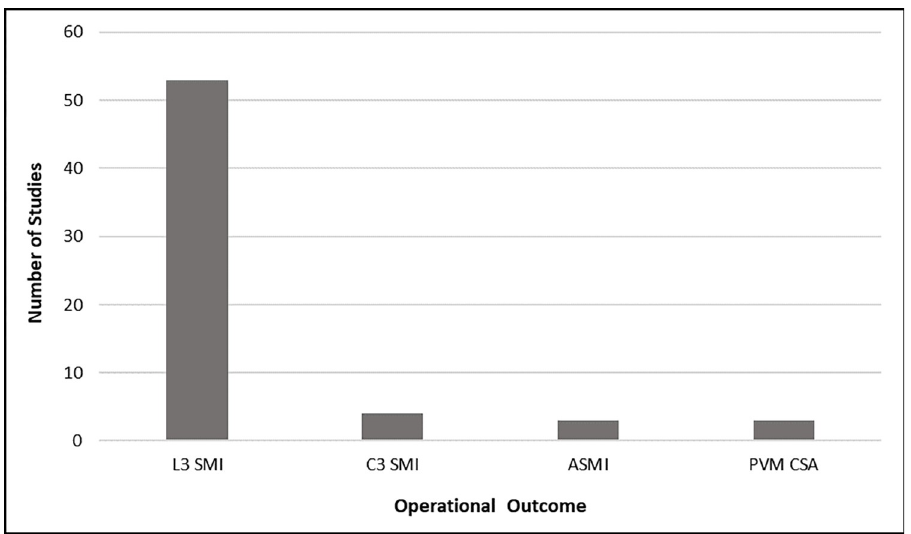
Fig 5. Prevalence of outcomes used to represent